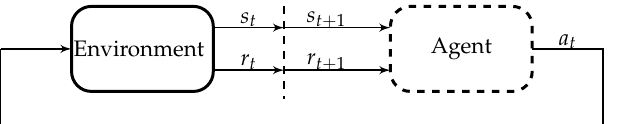
Figure 2. Reinforcement Learning